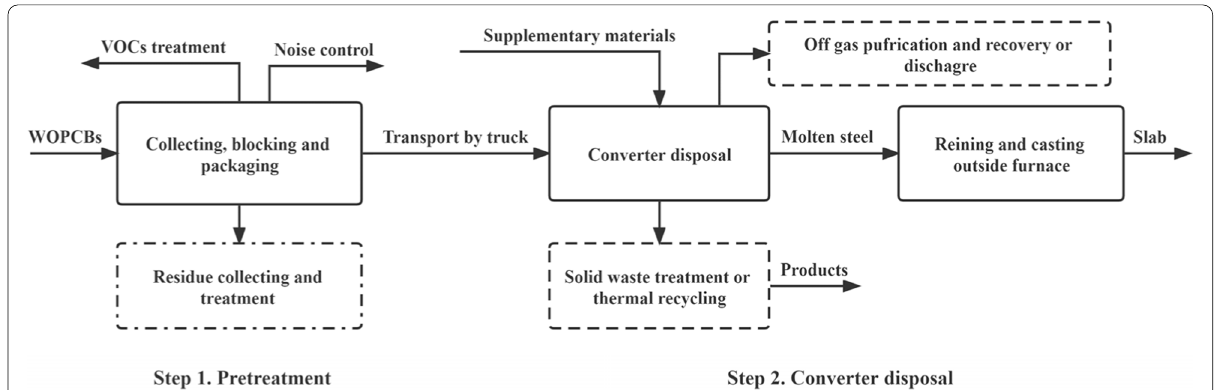
Fig. 1 Disposal process diagram of